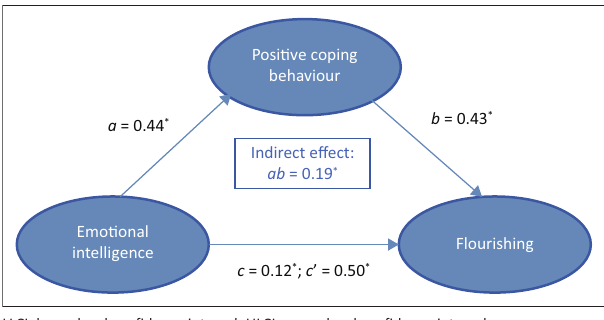
FIGURE 1: Mediating effect of positive coping behaviour.